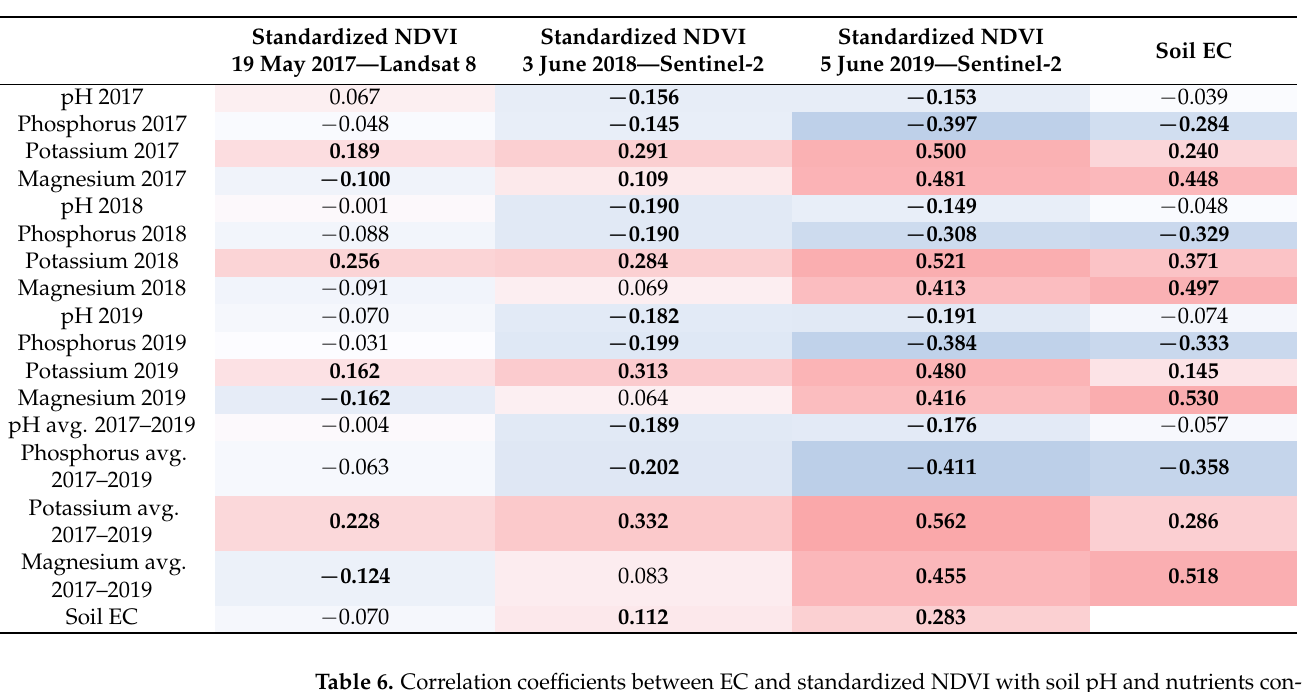
Table 5. Correlation coefficients between EC and standardized NDVI versus soil pH and nutrients content (significant correlations at 0.05 significance level are in bold; color background scale for correlations the same as in Table 4).